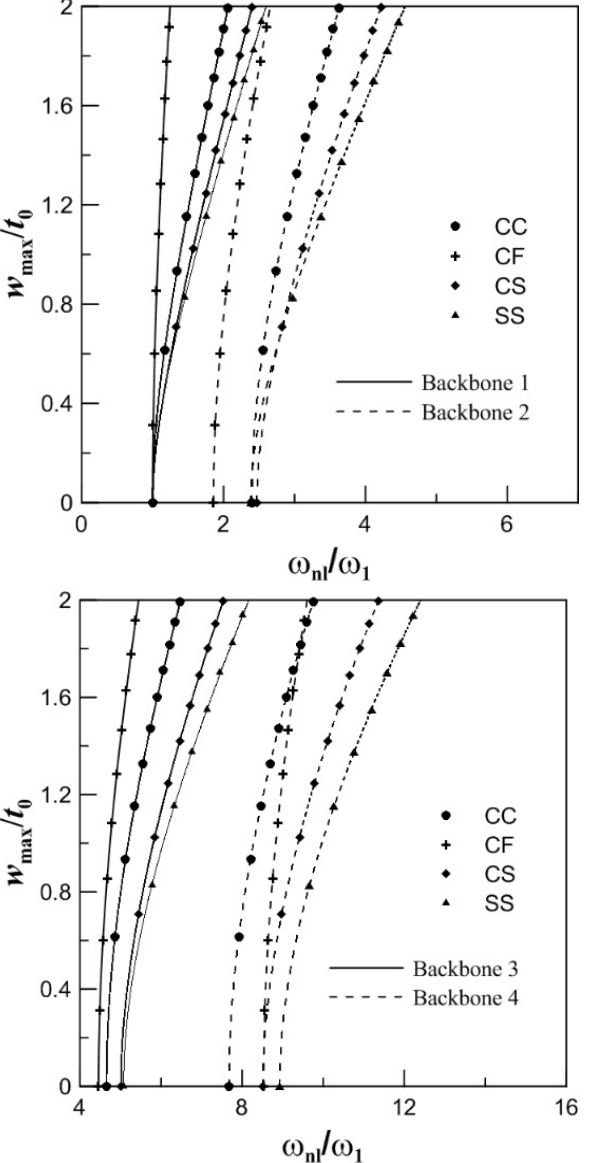
Figure 13: Backbone curves of parabolic taper AFG material (︀ E ( ξ ) = E )︀ for CC, CF, CS, SS boundary condition 0 e ξ , ρ ( ξ ) = ρ 0 e ξ at α = 0.4 and K = 10,000 N/m.